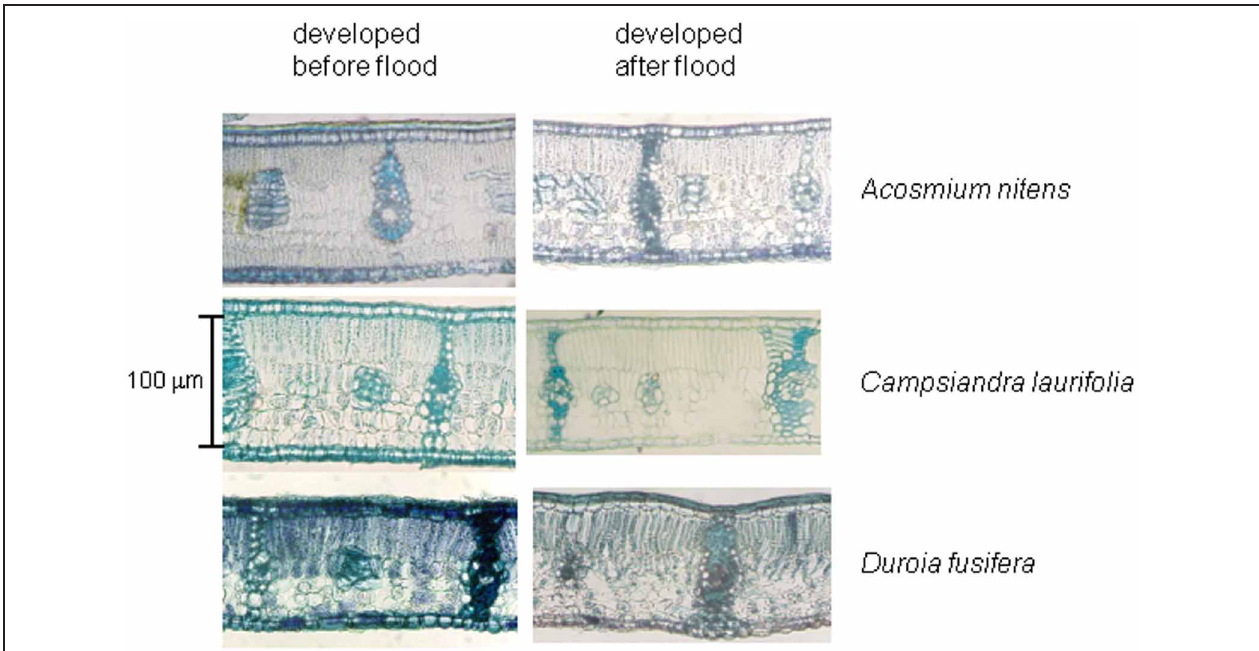
FIGURE 9 | Cross-sections of emerged leaves of the species indicated produced during drainage and after full flooding. The sections were stained with toluidine blue. Modified from Herrera et al.